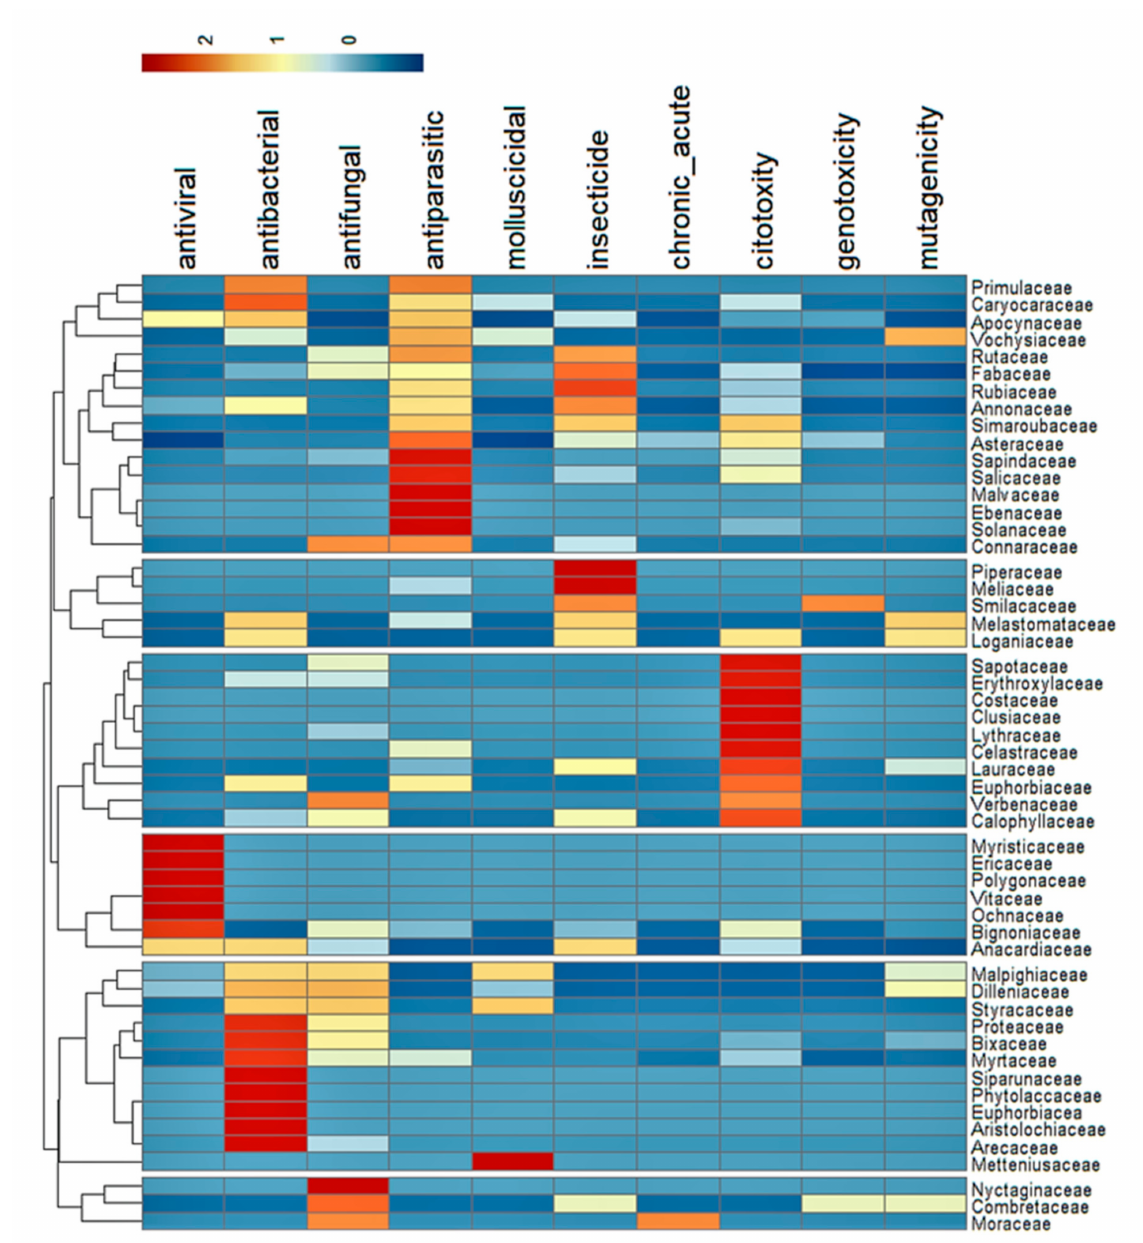
Figure 4. Heatmap of the plant families included in the present review grouped according to the frequency of the important bioactive properties associated with each